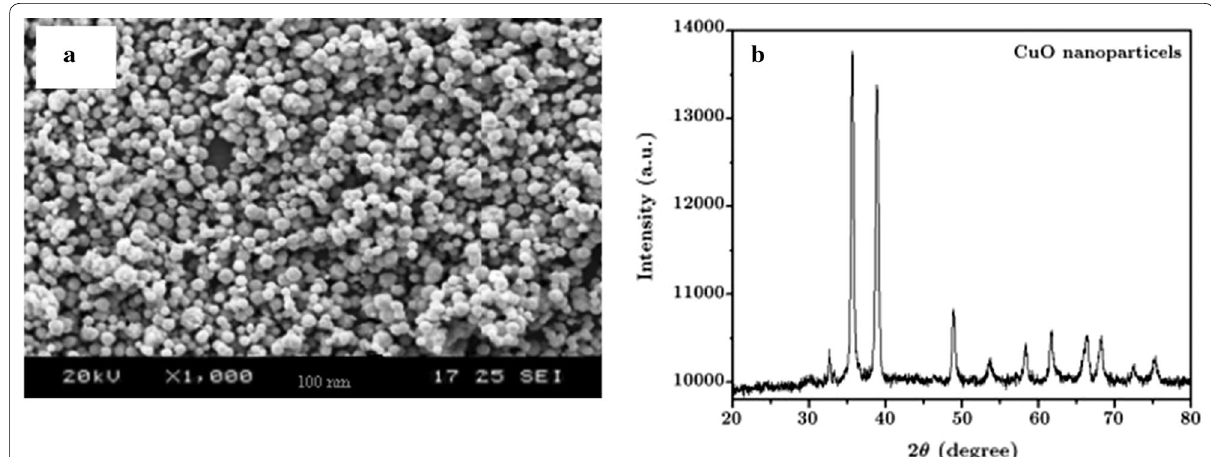
Fig. 2 SEM image ( a ) and XRD pattern ( b ) of CuO nanoparticles